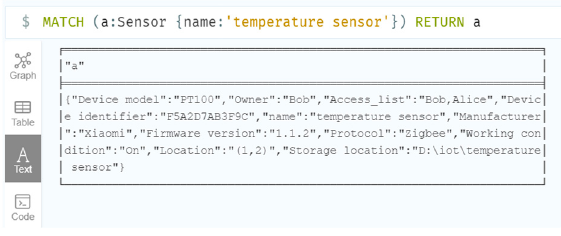
Figure 17. The remote monitoring equipment.